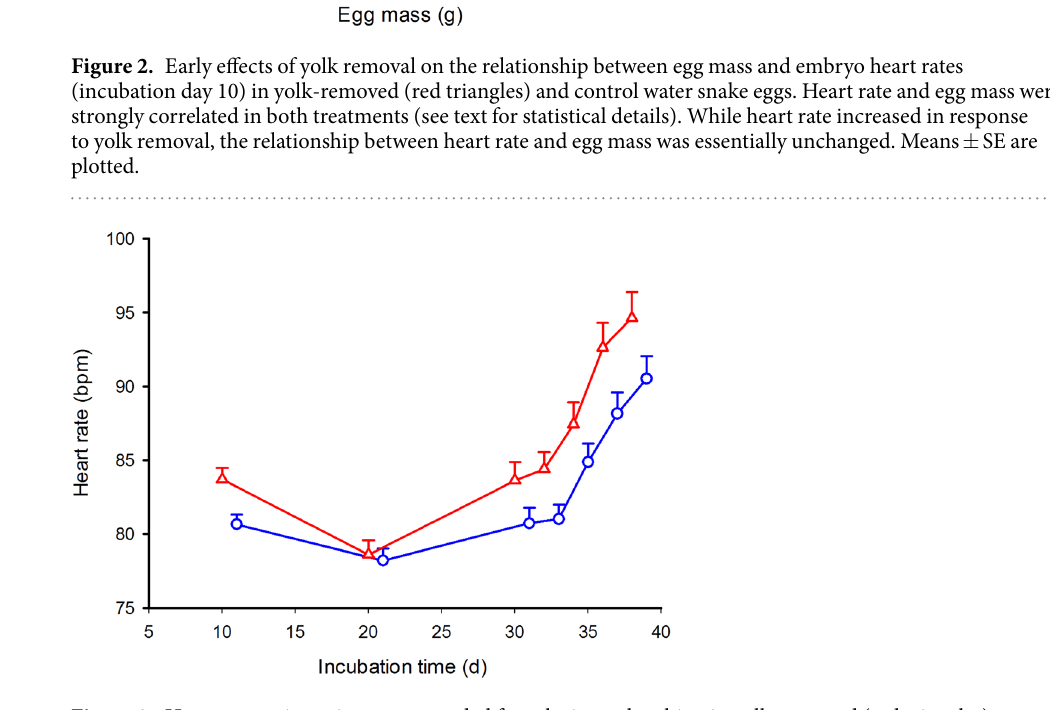
Figure 3. Heart rate trajectories were recorded from laying to hatching in yolk-removed (red triangles) and control water snake eggs (blue circles). A repeated measure two-factor Anova with clutch of origin and treatment as factors and 7 consecutive heart rate recordings as the repeated measure yielded: global interaction term F 12.92, 137.81 = 1.32, P = 0.21; effect of heart rates over time interaction; F 4.31, 1137.81 = 0.66, P = 0.63; effect of treatment F 1, 32 = 10.48, P < 0.0028. As the assumption for sphericity was violated (W = 0.026, χ 2 20 = 39.67; P < 0.0001), results were corrected using Greenhouse-Geisser adjustments. Means ± SE are